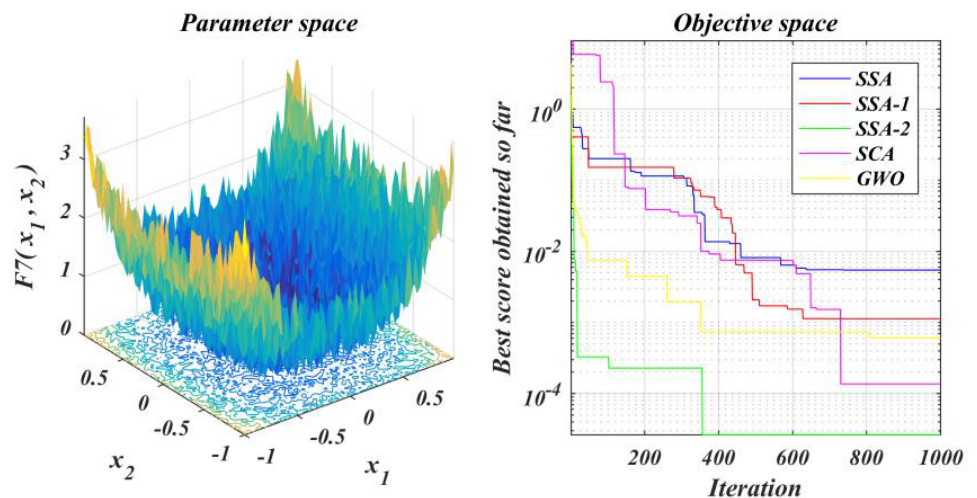
Figure 4. F7 Convergence curve.